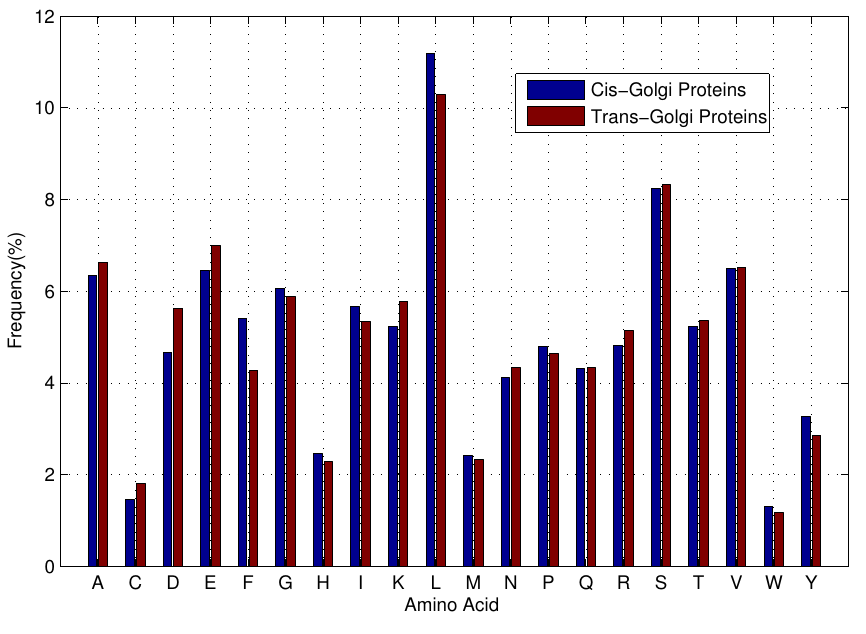
Figure 2. Average amino acid frequencies of cis -Golgi and trans -Golgi